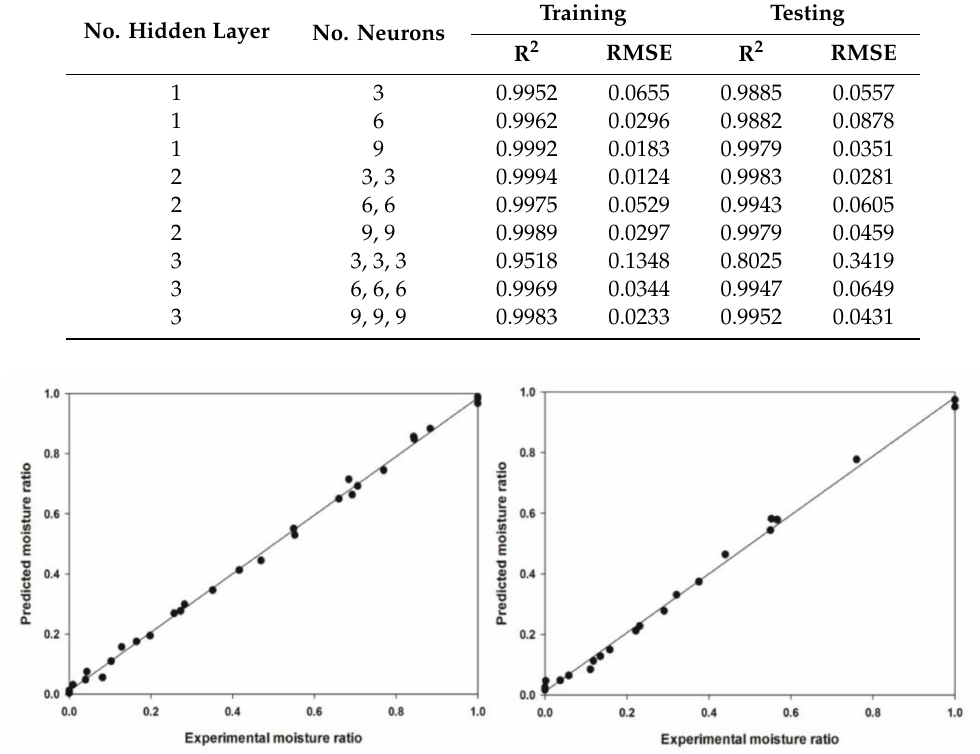
Table 9. Statistical results of drying kinetics of persimmon samples for the ANN model using HAD. No. Hidden Layer